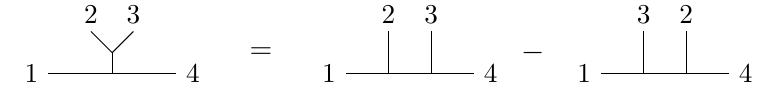
(cid:0) (cid:1) 1 ; (cid:26) (2 ; : : : ; n (cid:0) 1) ; n , correspond to half-ladder